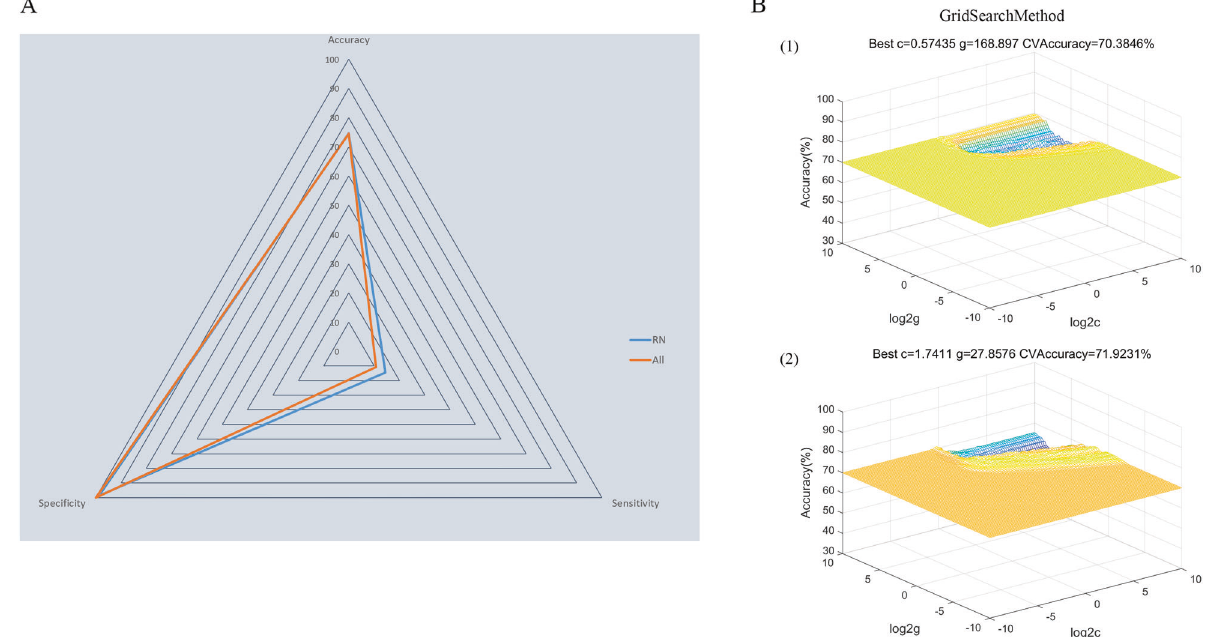
Fig. 3 Visualization of classi fi cation by SVM analyses. A The accuracy, sensitivity, and speci fi city of the classi fi cations of patients with recurrent MDD versus HCs using all signi fi cant NAc FCs as features or using signi fi cant NAc FCs within the reward network as features. B Parameter selection result for training set when using (1) all signi fi cant NAc FCs as features and (2) using signi fi cant NAc FCs within the reward network as features. FC functional connectivity, HC healthy controls, MDD major depressive disorder, NAc nucleus accumbens, SVM support vector